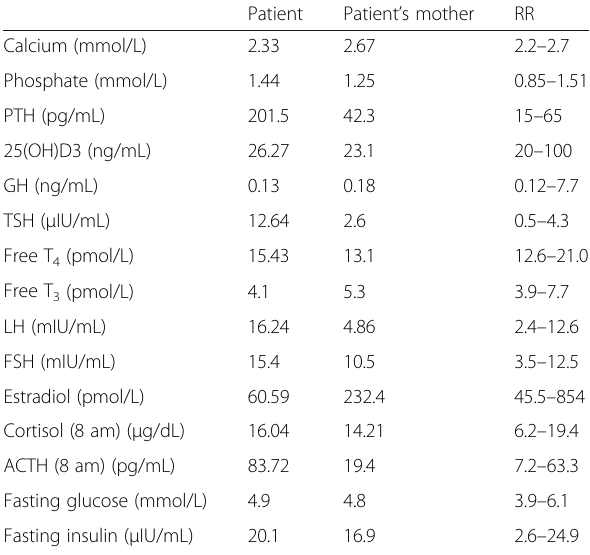
Table 1 Biochemical characteristics of the patient and her mother Patient Patient ’ s mother RR Calcium